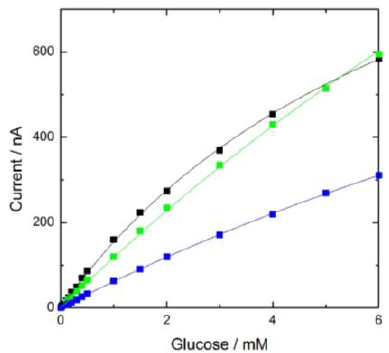
Figure 1. Calibration curves of glucose based on cellulose-based glucose oxidase membrane electrode. The black curve was obtained on the 2nd day after preparation. The green and the blue curves were obtained on 117th day and 329th day,